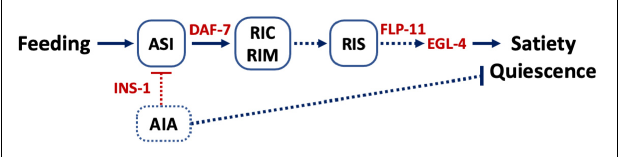
FIGURE 4 | Model. Feeding activates ASI and promotes ASI to release DAF-7, the C. elegans TGF β , which in turn activates the TGF β receptors on RIM and RIC (Gallagher et al., 2013b). This activation leads to activation of RIS and release of FLP-11 to induce satiety quiescence. The cGMP signal initiated from ASI is also required for satiety quiescence. Although the exact sites of cGMP signal are unknown, our data suggest EGL-4 could act downstream of FLP-11. INS-1 presumably released from AIA could serve as a negative feedback signal to ASI and inhibit satiety quiescence. Lines indicate signaling that has been previously reported whereas dotted lines are